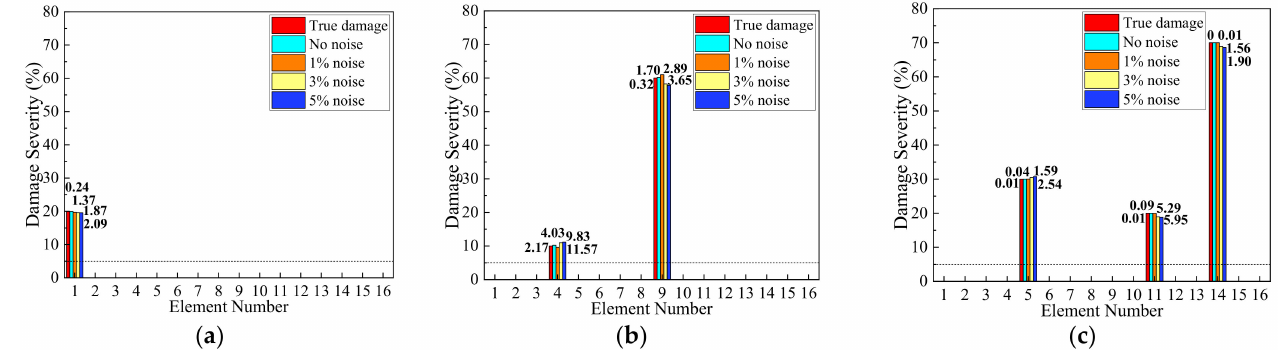
Figure 9. Damage identification results and corresponding errors for the ASCE benchmark frame. ( a ) Case 1; ( b ) Case 2; and ( c ) Case